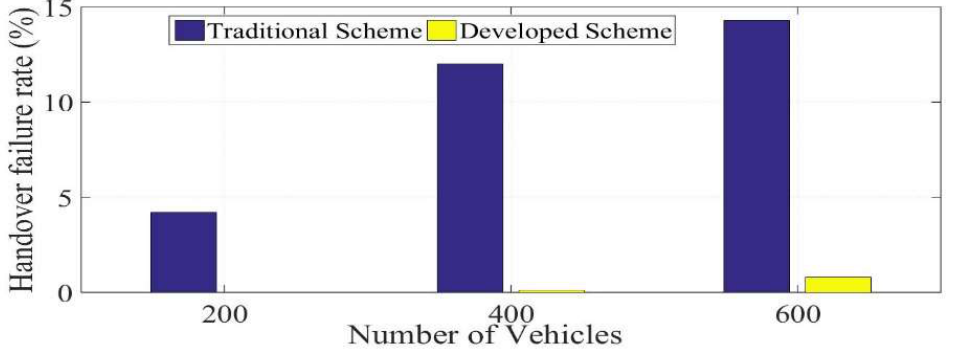
Figure 13. Handover failure rate of traditional handover schemes and the developed scheme with different numbers of deployed vehicles.